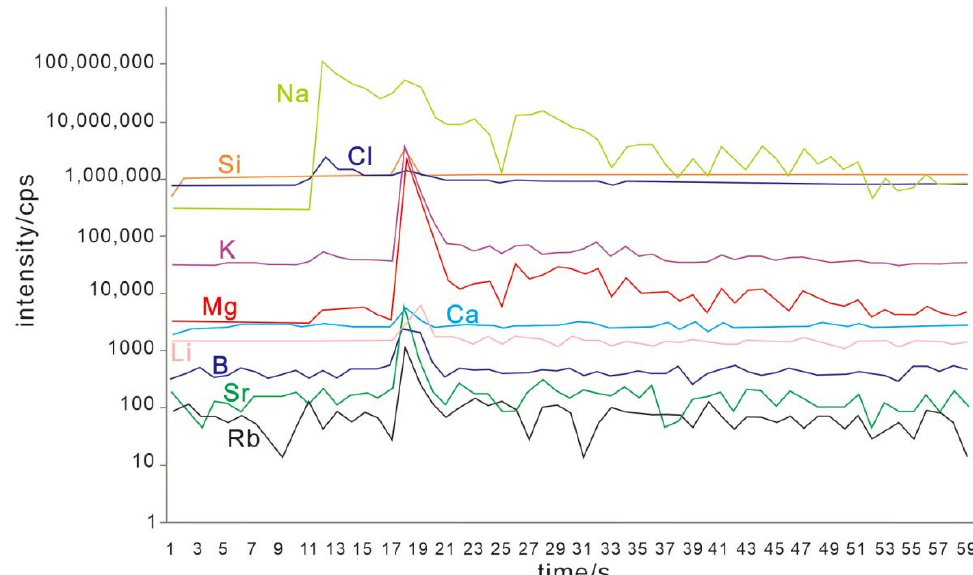
Figure 7. MS signal intensity vs. time for single fluid inclusion in halite.